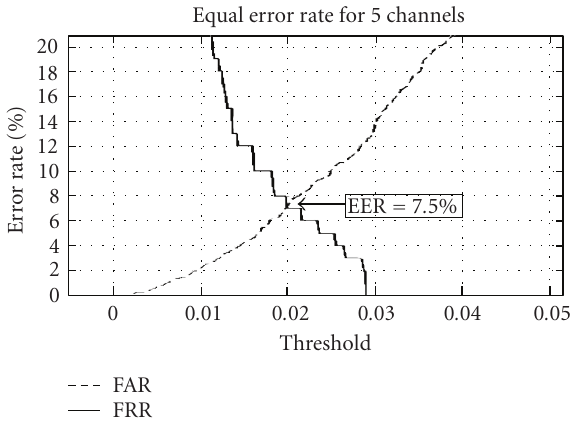
Figure 3.2 . EER for 5-channel